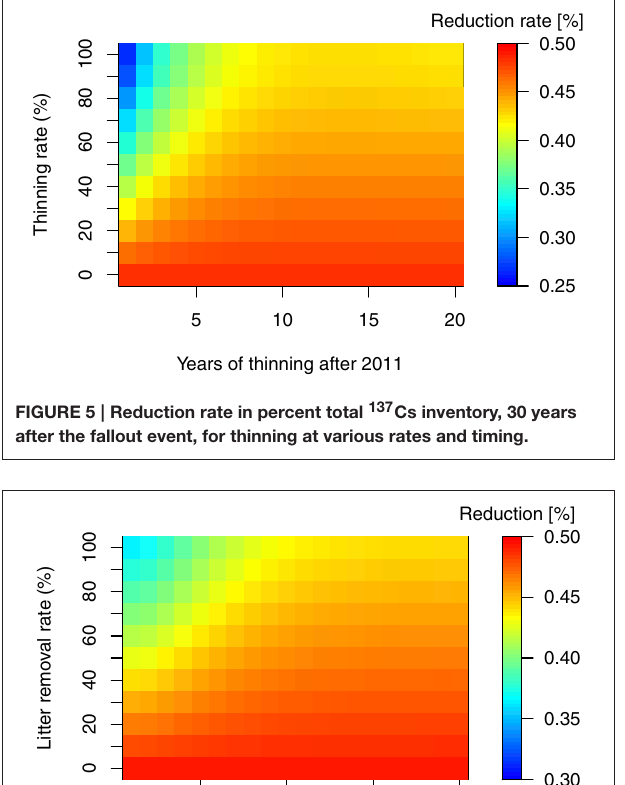
by decomposing litter layer ( Figure 2 ). Our result also